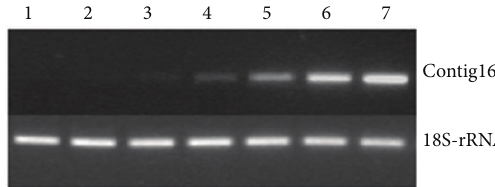
Figure 5: RT-PCR detection of Contig16 in different development stages of F. chinensis . Shrimps from different postlarvae (PL) stages were used for transcripts detection. 1–7 represented PL15, PL 30, PL45, PL60, PL75, PL90, and PL105, respectively. 18S-rRNA was used to normalize the amount of